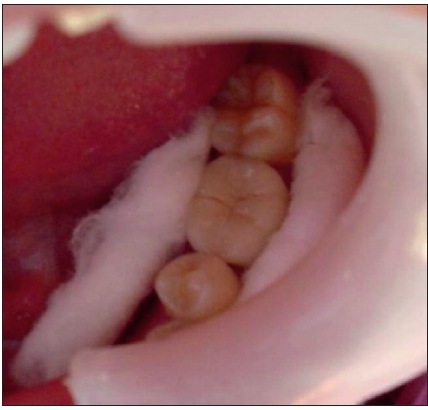
Figure 5: Occlusal view following final cementation. Figure 6: Buccal view of tooth 36 depicting the occlusion and imperceptible